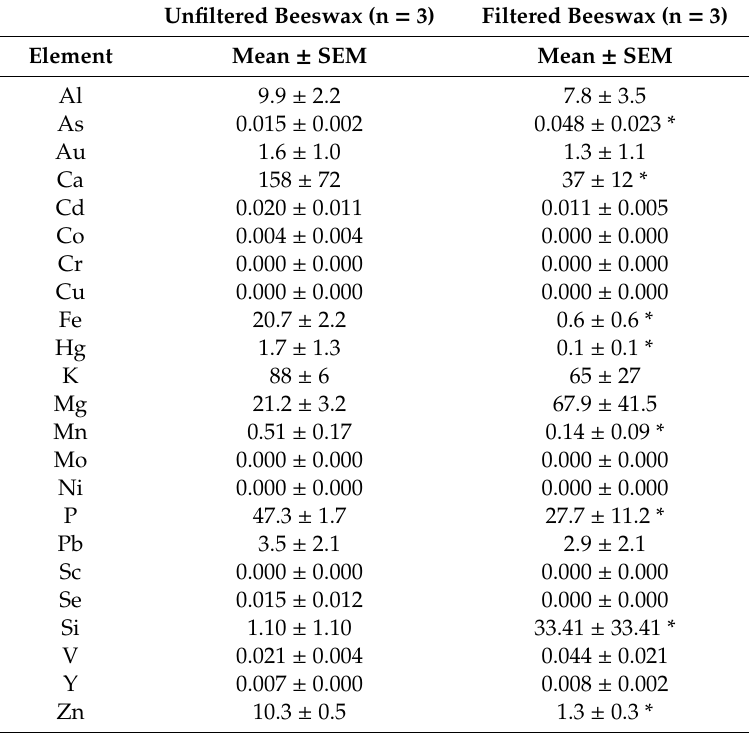
Table 4. Chemical elements in unfiltered and filtered beeswax samples. Results are expressed in ppm (mg /